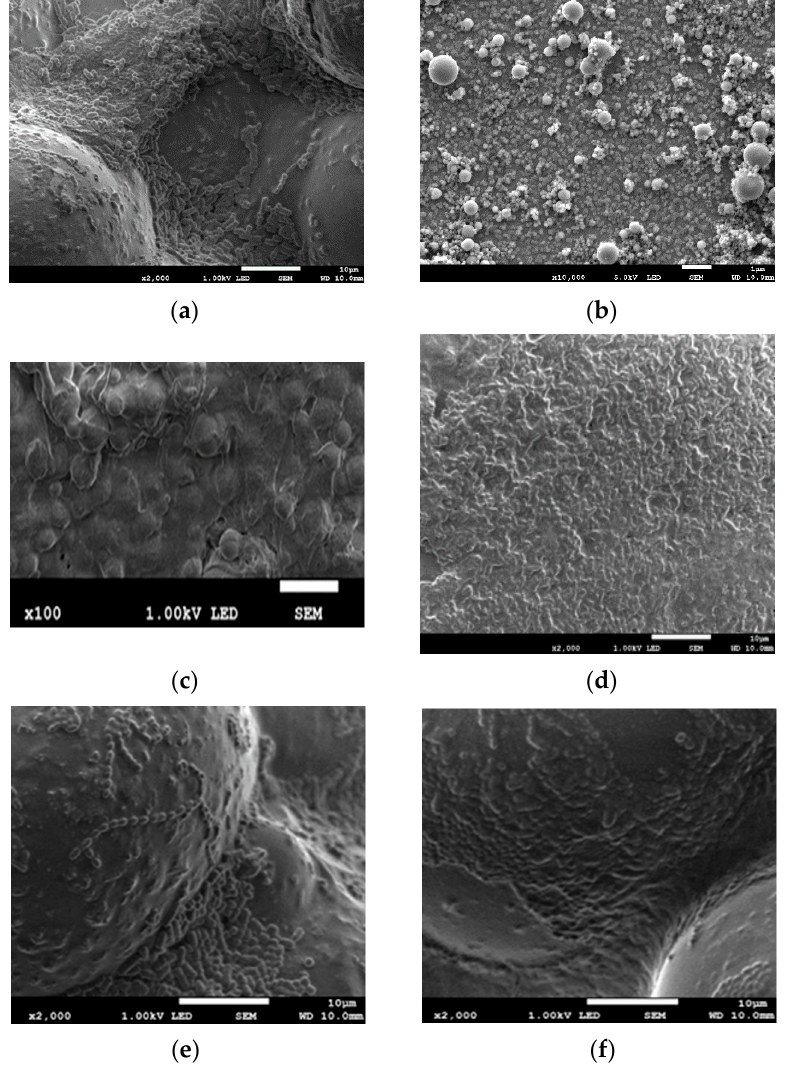
Figure 5. Results of the SEM evaluation of the bone cement surface after 6 months in the bacteria solution: ( a ) pure; ( b ) Ag; ( c ) Cu 10; ( d ) Cu 70; ( e ) Ni; ( f ) AgCu.